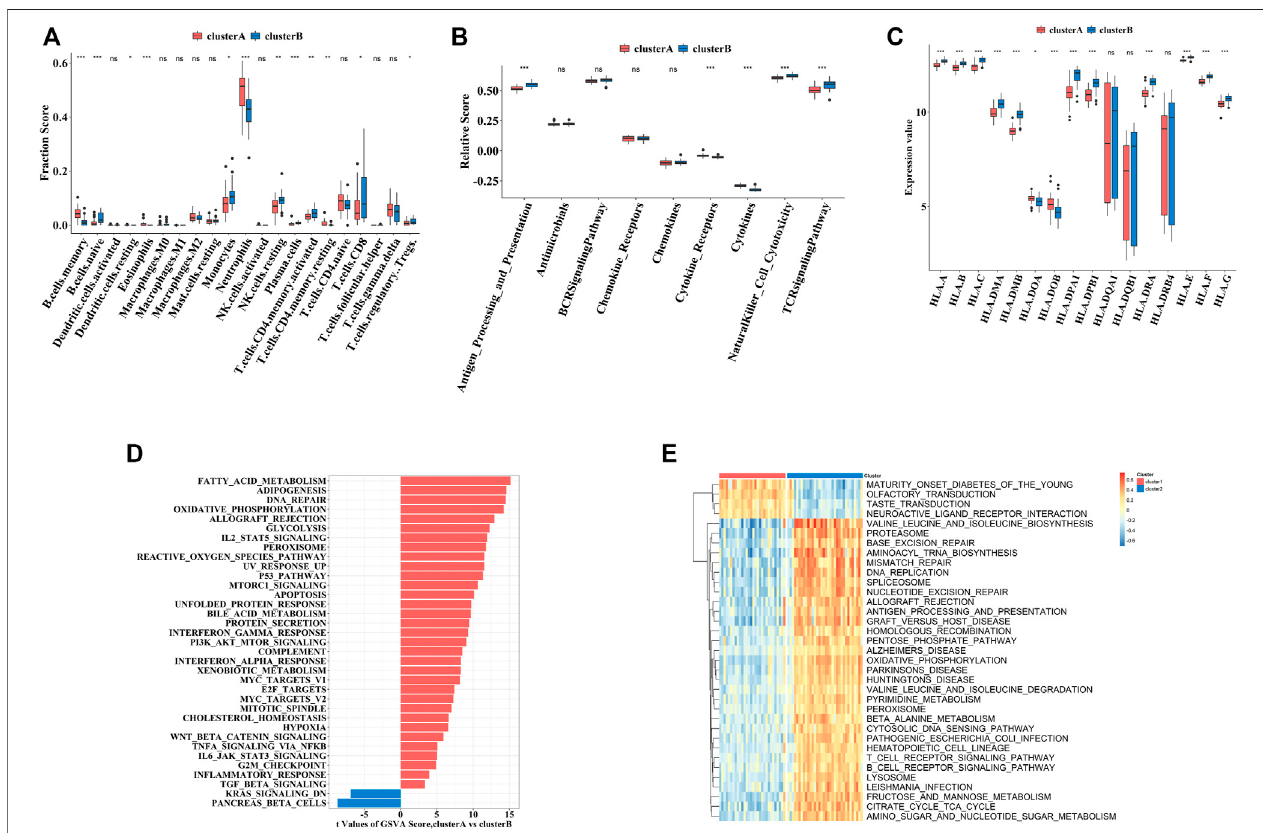
FIGURE8| Theimmuneandbiologicallandscapesoftwopyroptosis-related clusters (A – C) .Theresultsofimmunein fi ltratingcells (A) ,immuneresponsegeneset (B) , and HLA geneset (C) : boxplot map ofthe enrichmentscoresamongcluster Aand clusterB (D,E) .The results ofHallmark pathways (D) and Kyoto Encyclopedia of Genes and Genomes (KEGG) pathways (E) : heat map of the enrichment scores among cluster A and cluster B Adjusted p -values were showed as: ns, not signi fi cant; * p < 0.05; ** p < 0.01; *** p < 0.001.